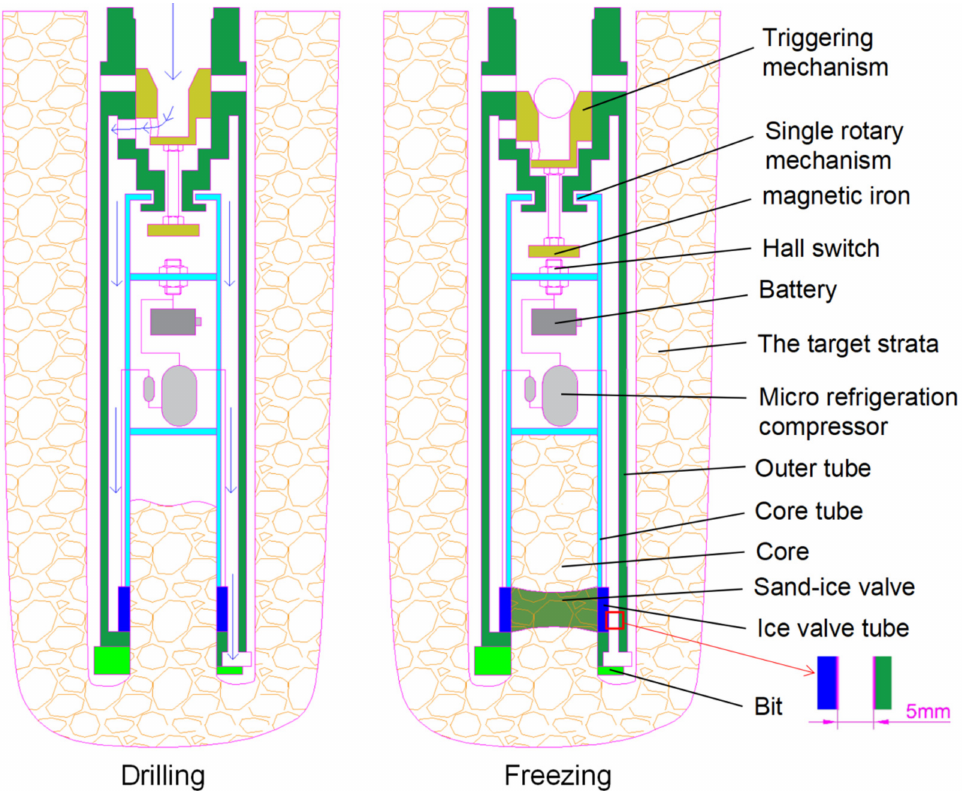
Figure 1. Schematics of the novel ice coring